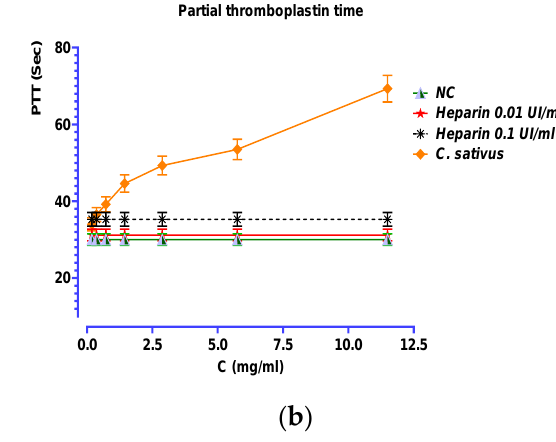
Figure 8. Effect of C. sativus decocted extract (E 0 ), normal control (NC), and heparin on prothrombin time ( a ) and partial thromboplastin time ( b ).